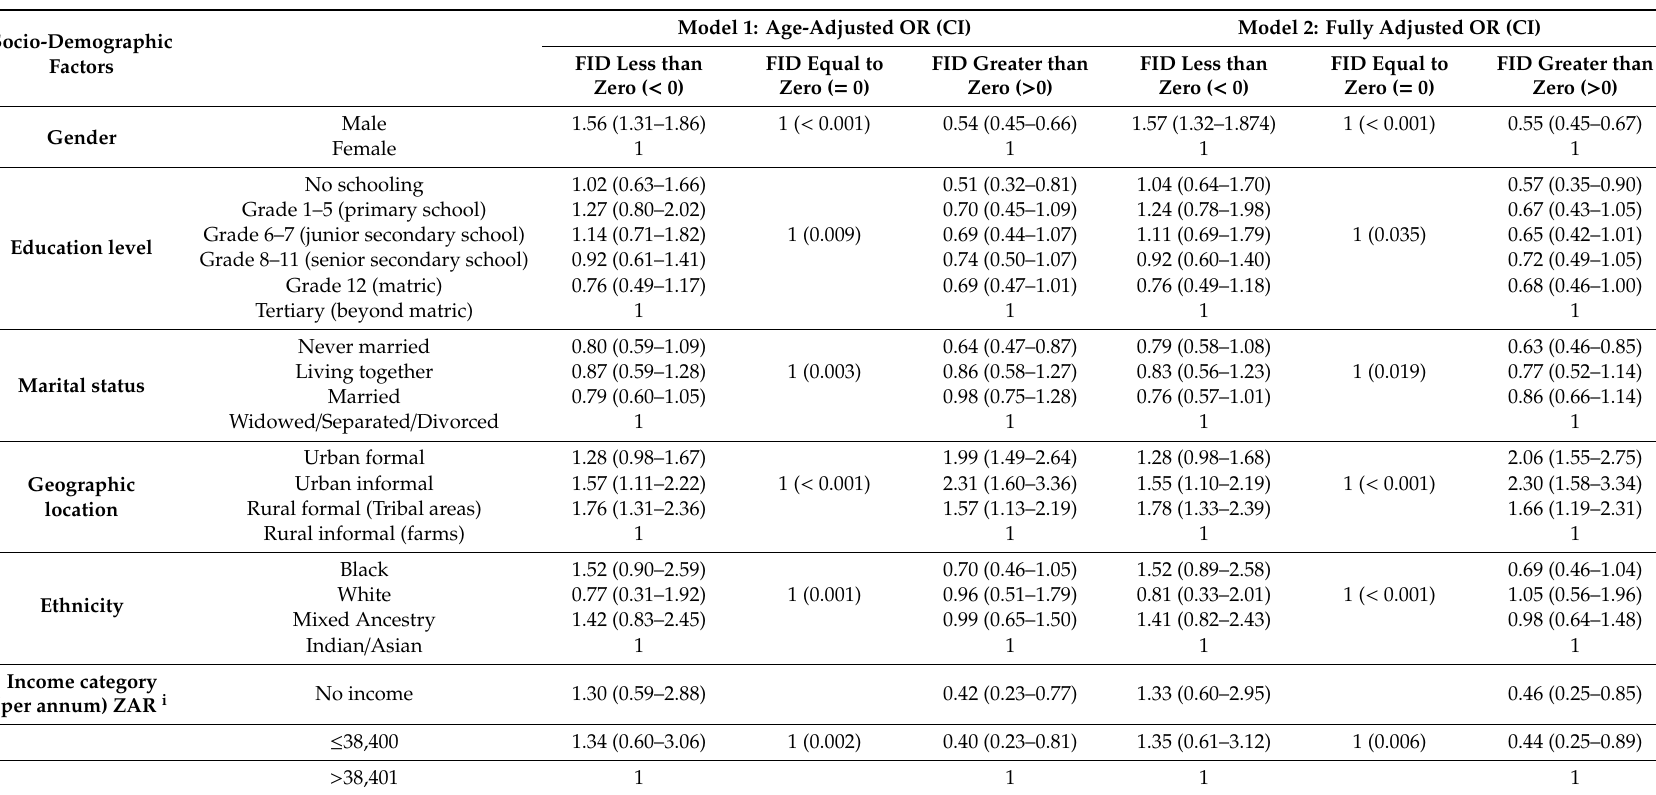
Table 4. The likelihood of feel–ideal discrepancy (FID) among participants from the SANHANES-1 survey by indicators of sociodemographic factors (age-adjusted and fully adjusted odds ratios from multinomial